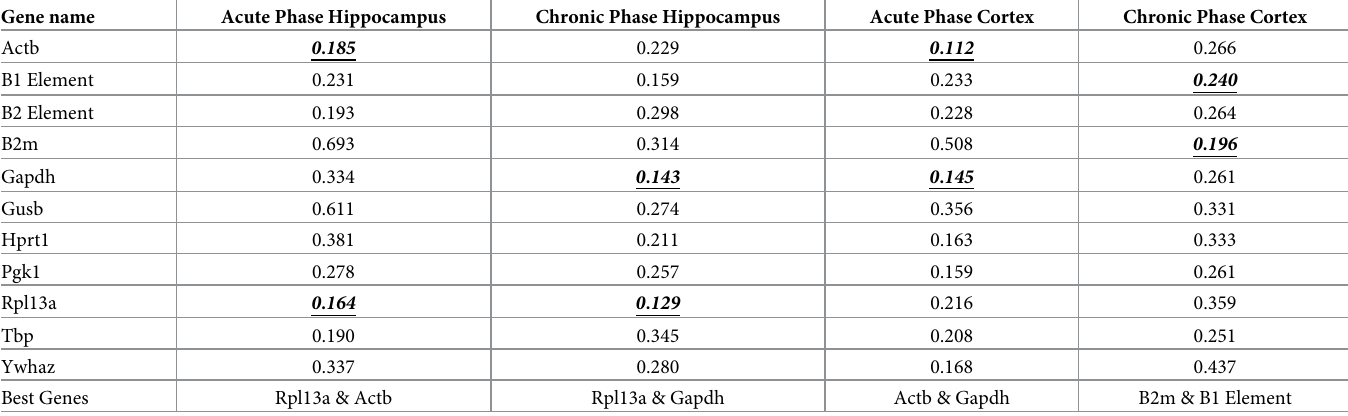
Table 3. A NormFinder analysis of the acute (acute phase control vs. T10) and the chronic (chronic phase control vs. T80/T120) phase in the hippocampus and cortex.